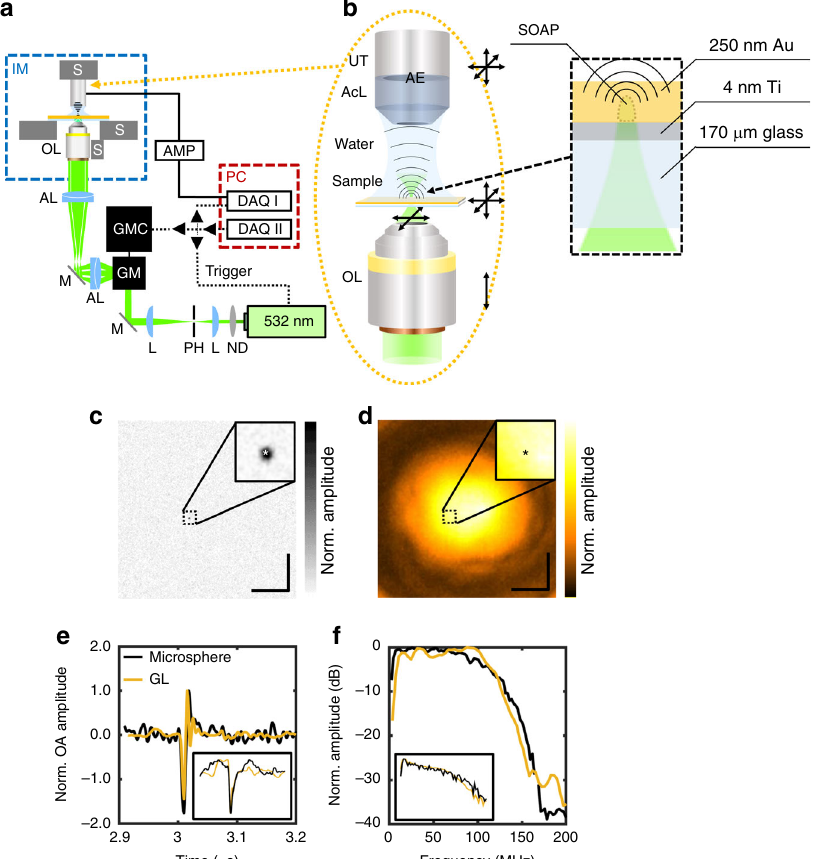
Fig. 1 The OR-OAM system used for TIR characterization utilizing signals from a gold layer and a 1- µ m black polystyrene microsphere. a OR-OAM system based on raster scanning an optically focused 532-nm laser excitation across a sample placed in an inverted microscope using galvanometric mirrors. b Close-up depiction of the arrangement of the imaging framework and schematic depiction of the generation of SOAPs; arrows indicate degrees of freedom within the OR-OAM system. c OR-OAM MAP onto the xy -plane of a black polystyrene microsphere. d OR-OAM MAP of a gold layer at the same axial position. e Raw OR-OAM signals and corresponding impulse responses (inset) of the positions in ( c ) and ( d ) marked with asterisks. f Frequency content of the microsphere (black) and the gold layer (gold), and their corresponding frequency responses (inset). Scale bar, 100 µ m. AcL acoustic lens, AE active element, AL achromatic doublet lens, AMP low noise ampli fi er, DAQ data acquisition card, GM galvanometric mirror scanner, GMC GM controller, IM inverted microscope, L plano-convex lens, M dielectric mirror, ND neutral density fi lter, OL microscope objective lens, PH pinhole, S high-precision motorized stage, SOAP spatially distributed optoacoustic point source, UT ultrasound